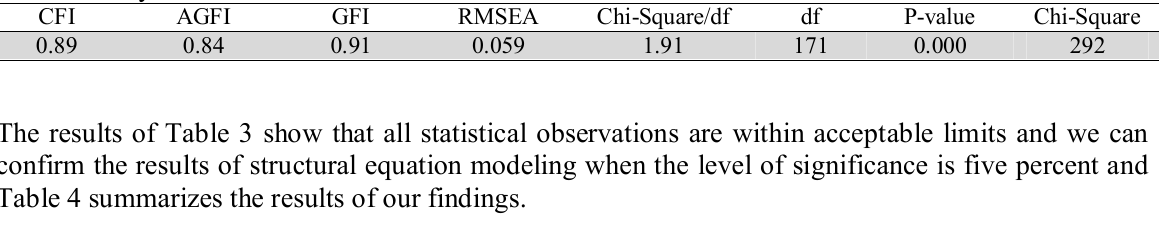
The summary of testing various hypotheses Component coefficient t-value Result Green product influences positively on customer loyalty. √ Green price influences positively on customer loyalty. √ Green distribution influences positively on customer loyalty. √ Green promotion influences positively on customer loyalty.